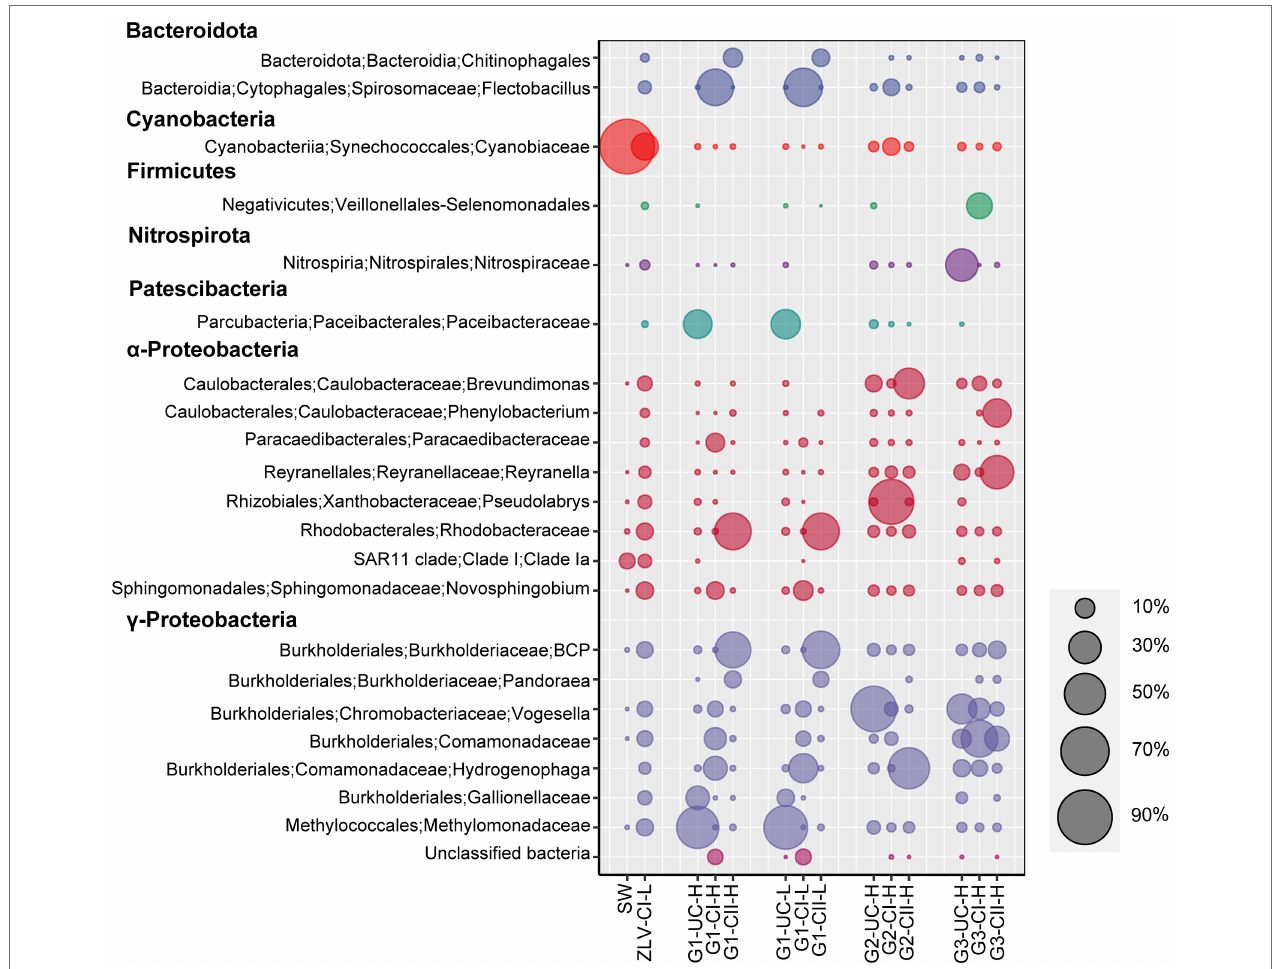
FIGURE 6 | Bubble chart of the relative abundance of bacterial lineages at the genus level. The graph shows bacterial lineages with relative abundance greater than 3% in all of the samples, bubbles of different sizes represent the relative abundance of each group, and the relative abundance ratio represented by the bubble size is listed on the right side of the graph. Aggregation was performed at the genus level, some groups are annotated only to family in the Silva (138) database, so their names at genus level are not indicated in the figure. G1, G2 and G3 indicate monitoring site. ZLV, groundwater outlet at Zhuoluo; SW, seawater; UC, unconfined aquifer; CI, confined aquifer I; CII, confined aquifer II; H, high tide; L, low tide. BCP: